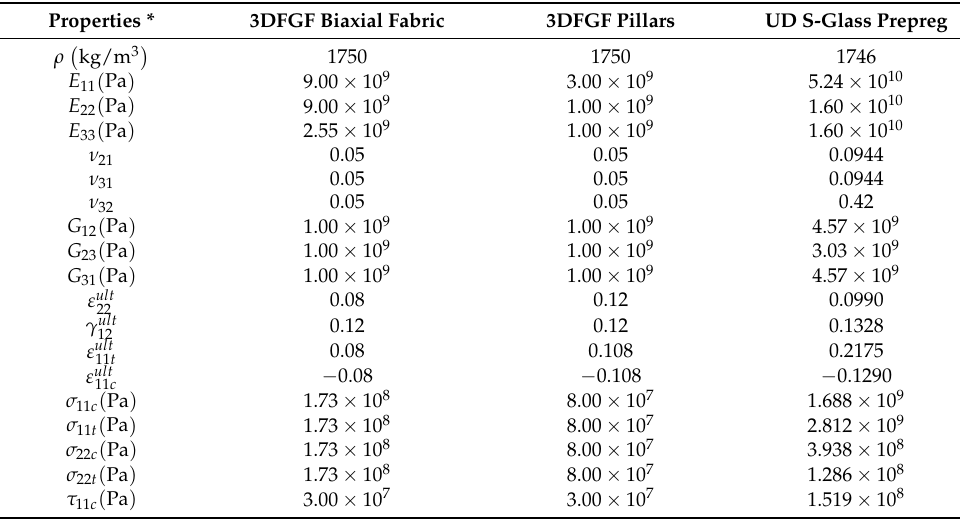
Table 2. Values of the parameters used in